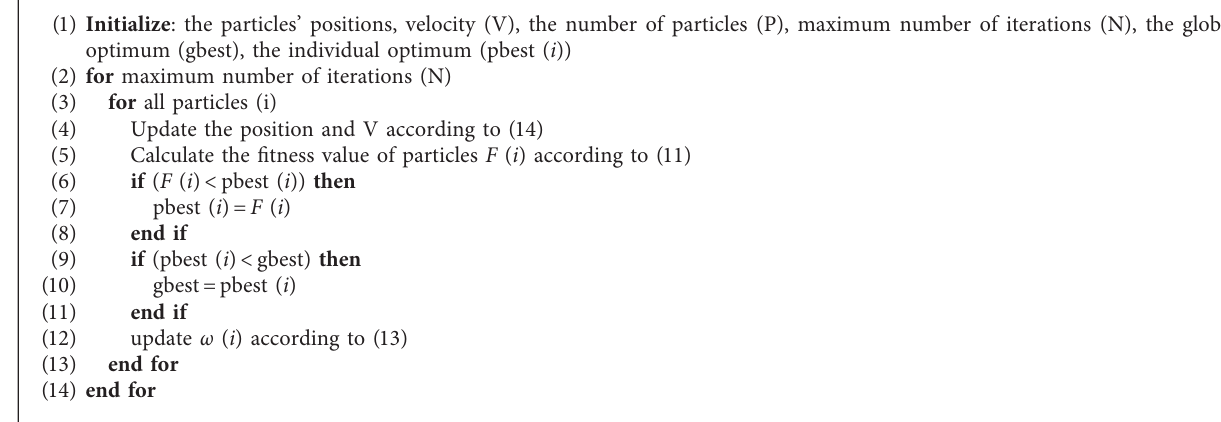
A LGORITHM 2: RMPSO